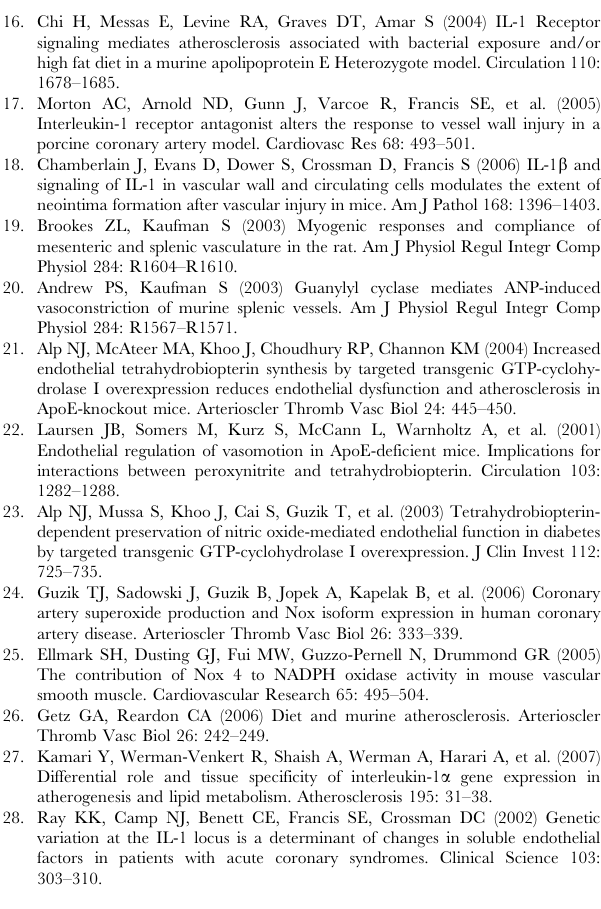
Table S2 Plasma levels of IL-1ra, IL-1 b , IL-1 a and IL-6 in ApoE 2 / 2 /IL-1R1 2 / 2 and ApoE 2 / 2 mice fed chow, Western